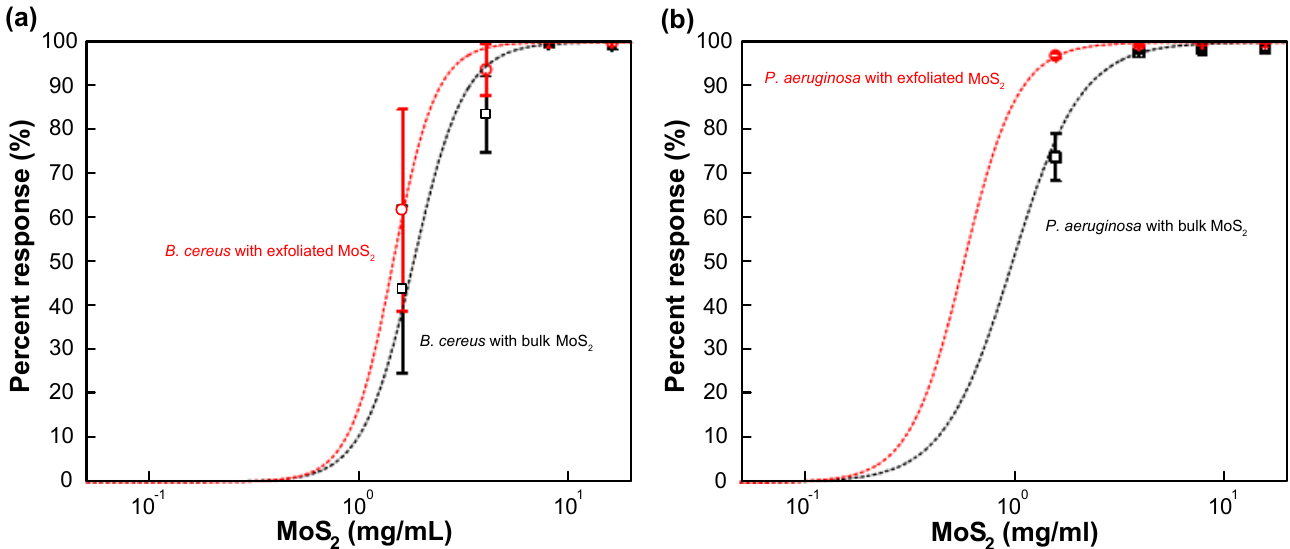
Figure 5. Dose–response curve of ( a ) B. cereus and ( b ) P. aeruginosa against bulk and exfoliated MoS 2 . The error bars rep ‐ resent the standard error of the mean.